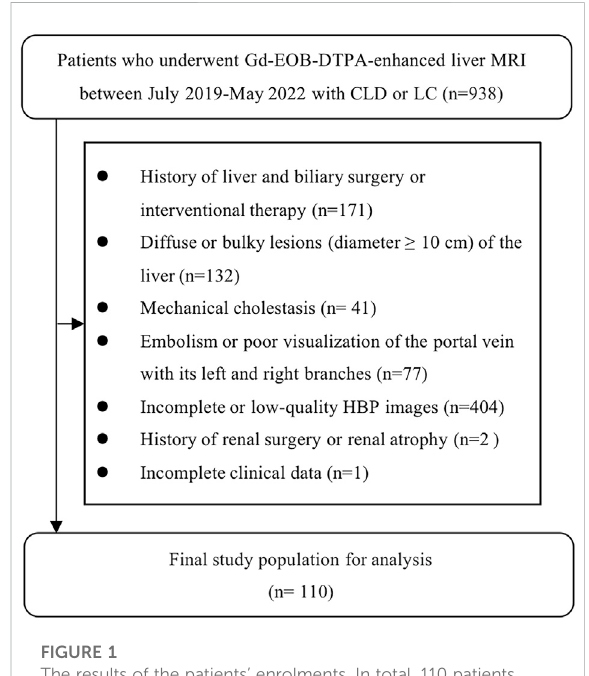
FIGURE 1 The results of the patients ’ enrolments. In total, 110 patients were enrolled in this